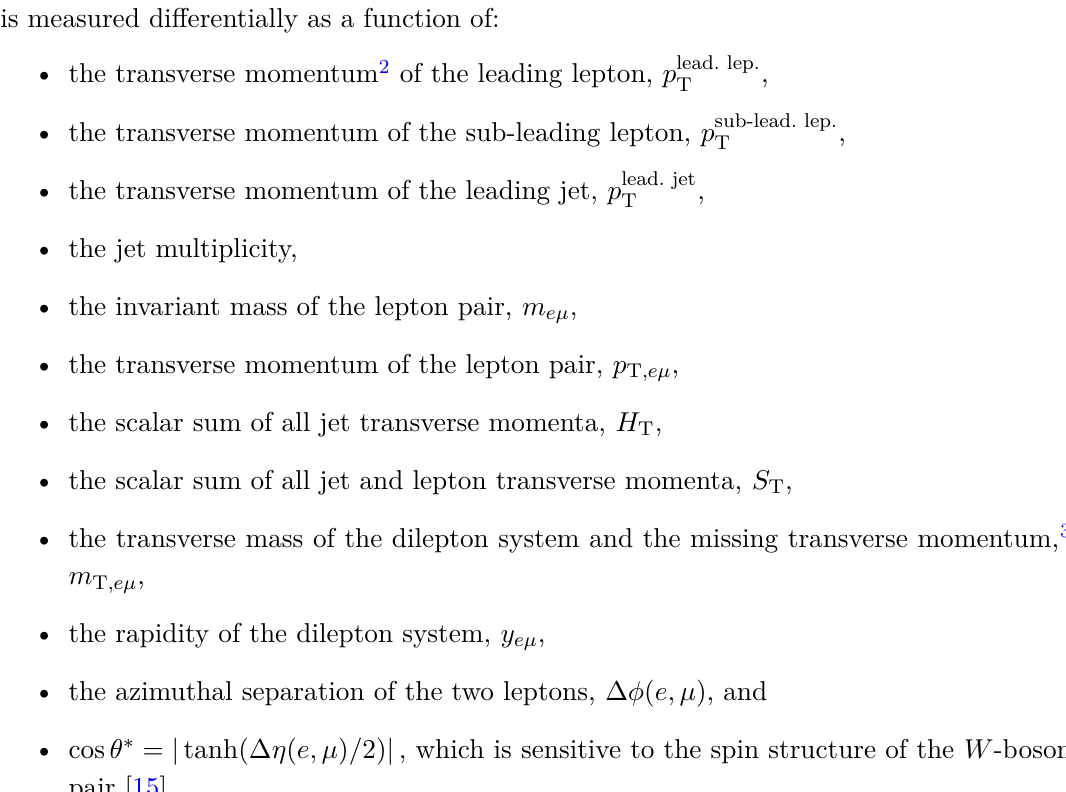
calibration, and provides a precise and accurate estimate of the background up to partonic centre-of-mass energies of the order of 1 TeV and for up to five